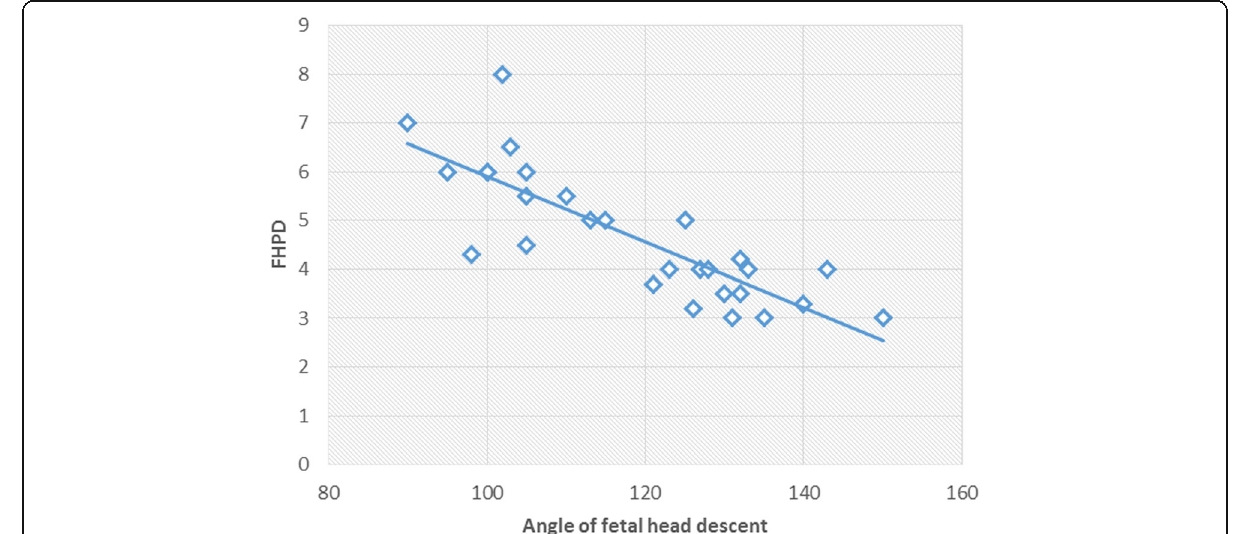
Fig. 7 Correlation between FHPD and angle of fetal head